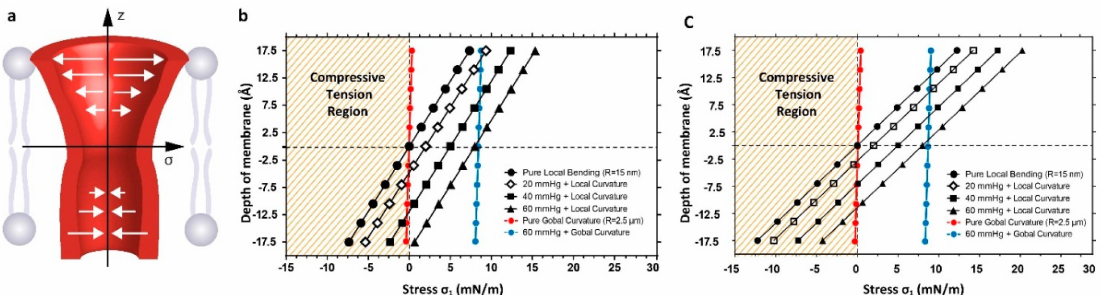
Figure 7. Stress distribution along the membrane thickness in response to outward bending (outward bending). ( a ) Schematic stress distribution along the channel in the lipid bilayer showing two distinct regions, which experience compressive and tensile stress; ( b ) Normal stress ( σ x ) distribution due to the local curvature and superposition of suction pressure of 20, 40 and 60 mmHg for a radius of curvature of R L = 25 nm and ( c ) radius of curvature R L = 15 nm. The red line in both illustrates the stress distribution in the presence of global curvature R G = 2.5 µ m alone while the blue line represents global curvature superimposed on 60 mmHg applied pressure. The pressure profile is the opposite under inward